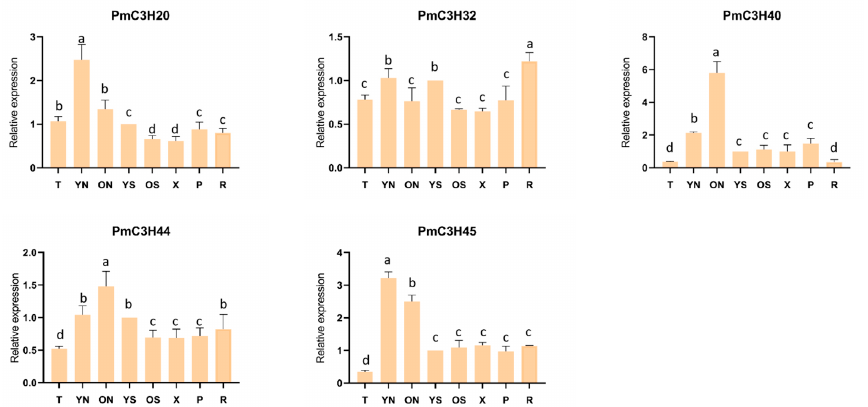
Figure 5. Relative expression of RR-TZF genes in eight representative tissues. T: Shoot apices; YN: young needle; ON: old needle; YS: young stem; OS: old stem; X: xylem; P: phloem; R: root. Same lowercase letter between different columns indicates no significant difference. Completely different lowercase letters between different columns indicate a significant difference, p < 0.05. The relative expression in YS was set as “1”.